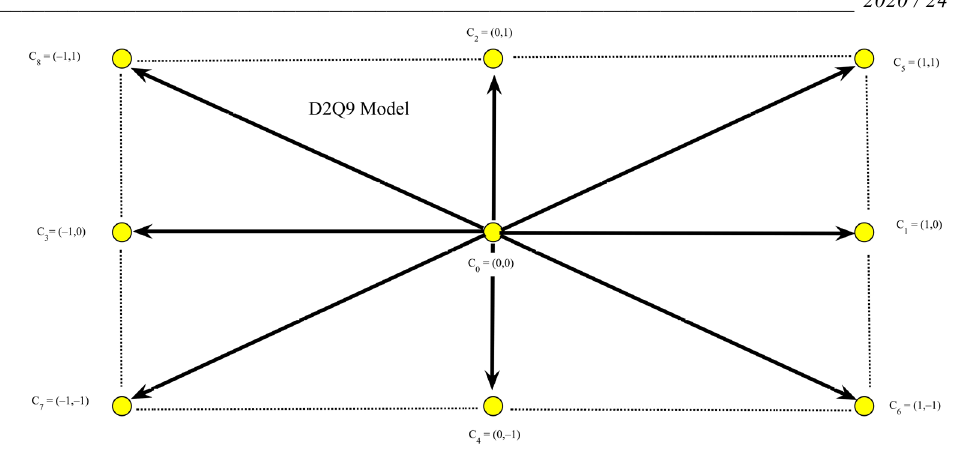
Fig. 2. The geometry of D2Q9 lattice with the lattice velocity c i